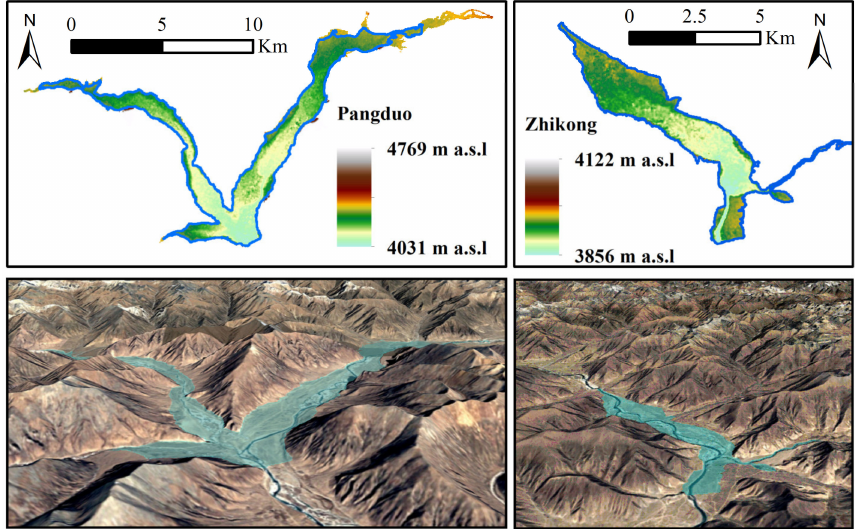
Figure 5. Bathymetry of the PDR and ZKR; the 3D topographic map of the PDR and